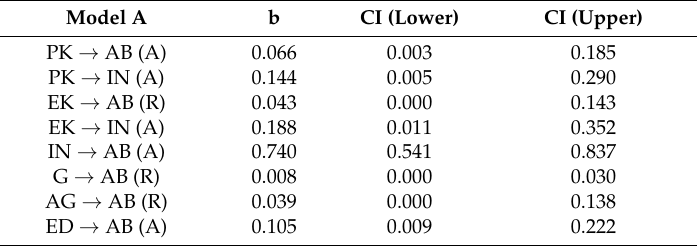
Table 3. Supported and unsupported relationships of the two structural equation models (SEM) by hypotheses testing based on bootstrapping with individual changes algorithm. Model A: planned behavioral model; Model B: habitual behavioral model; CI: confident interval; b: path coefficient; A: accepted hypothesis; R: rejected